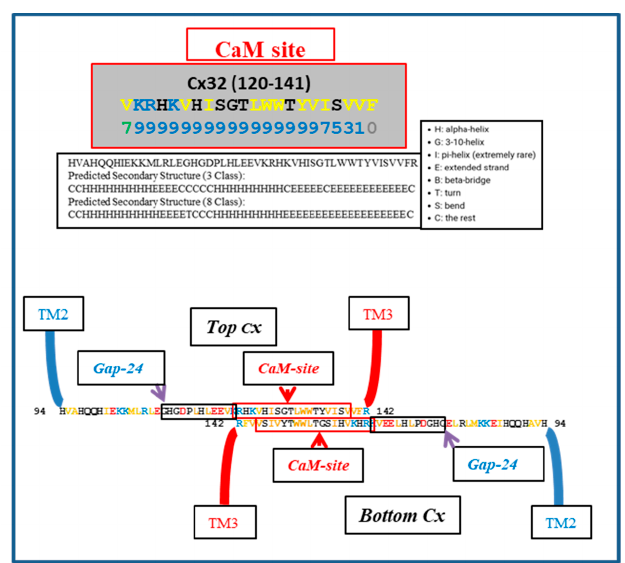
Figure 5. Hypothetical CL–CL interaction between Cx32 sequences. If present, the interaction